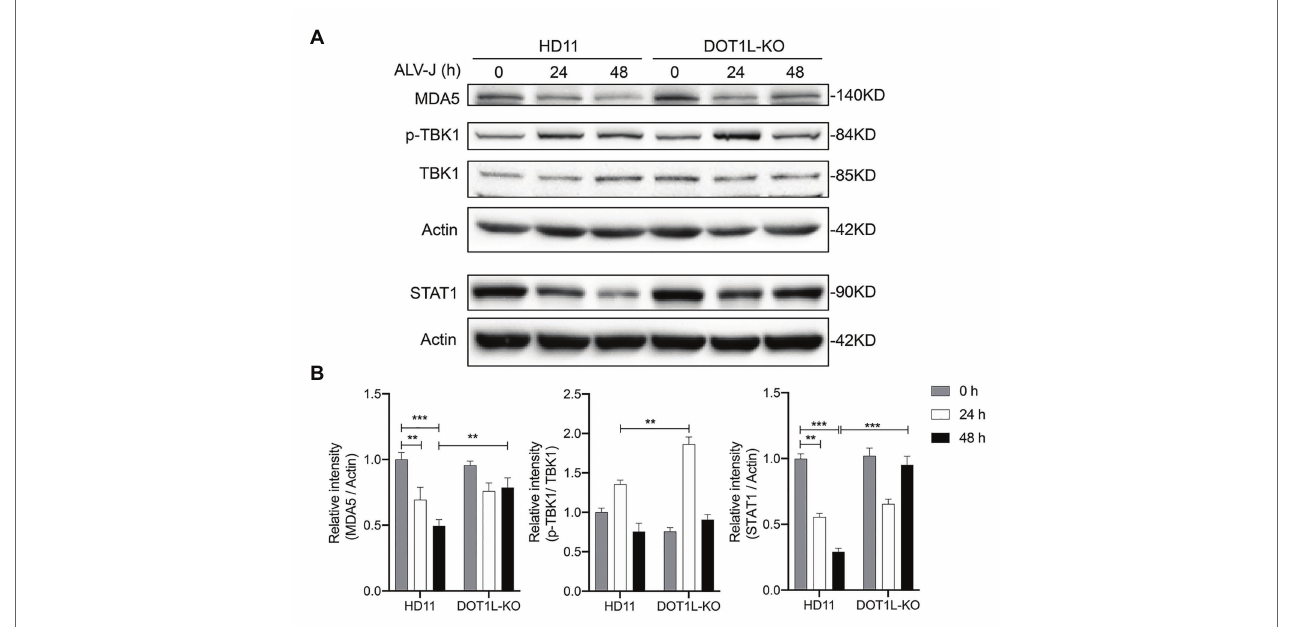
FIGURE 8 | Disruptor of telomeric silencing 1-like deficiency restores the innate immune response to ALV-J infection in a time-dependent manner. (A) HD11 cells and DOT1L-KO cells were infected with ALV-J (MOI 2). Cell lysates were prepared at 0, 24, and 48 hpi for western blot to detect the protein expression levels of MDA5, total‐ and phospho-TBK1, STAT1, and β -actin. (B) Relative protein levels were quantified by densitometry using ImageJ software. All the data were shown as mean ± SD (error bars) from three independent experiments. ** p < 0.01; *** p < 0.001; unpaired, two-tailed Student’s t